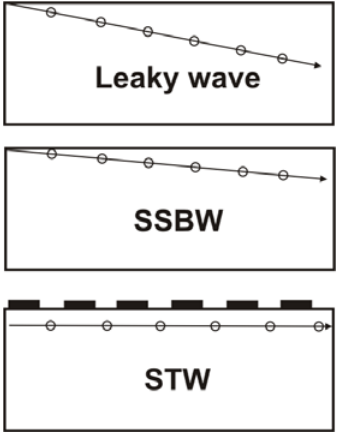
Figure 14. Wave propagation angles of Leaky, SSBW and STW